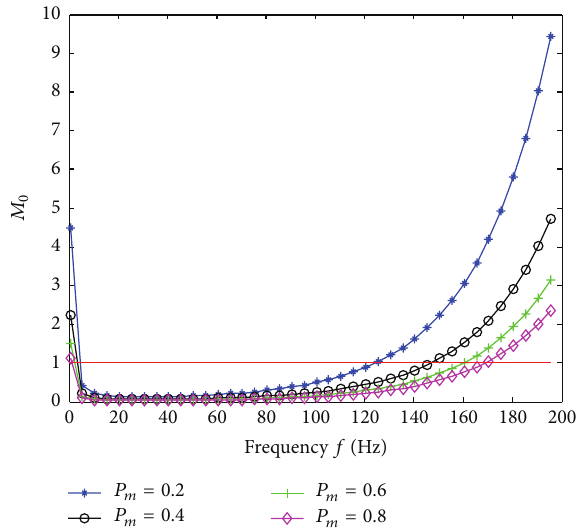
Figure 5: The curves of 𝑀 0 with 𝑑 under different excitation amplitudes.